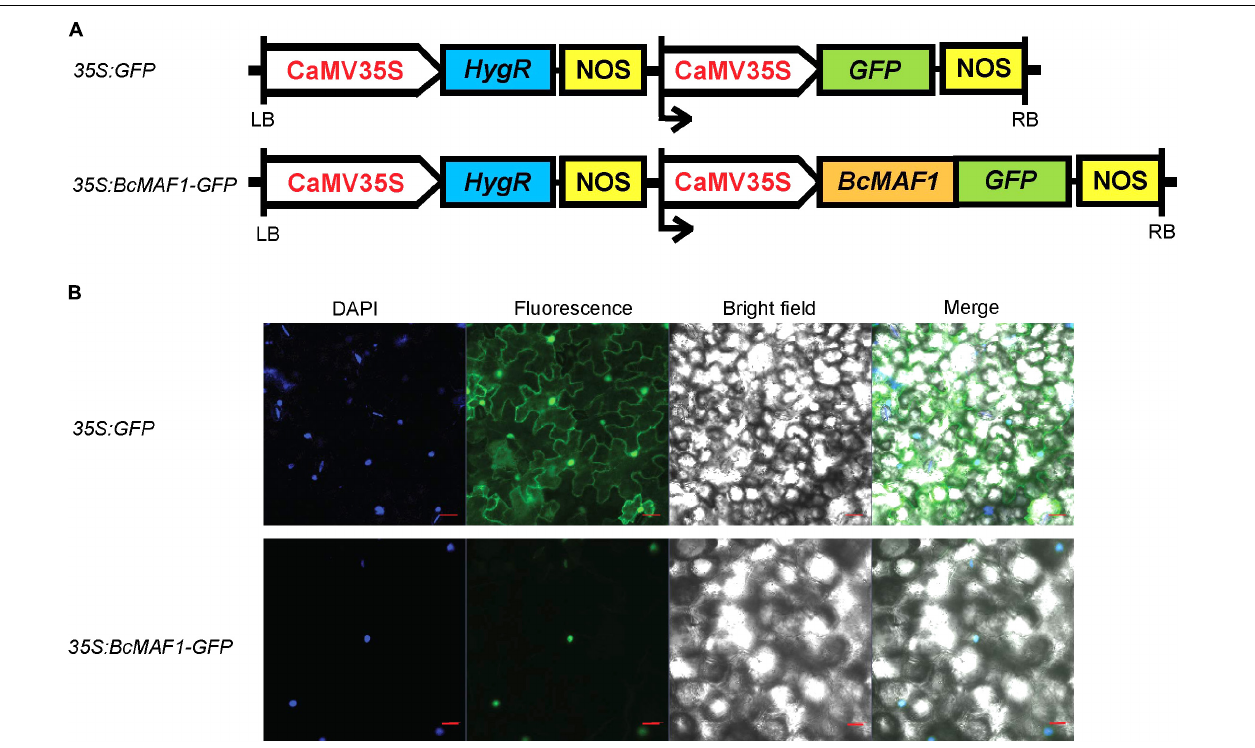
FIGURE 2 | Subcellular localization of BcMAF1 protein. (A) 35S:GFP and 35S:BcMAF1-GFP construct. (B) Transient expression of 35S:GFP (Scale bars = 50 µ m) and 35S:BcMAF1-GFP fusion protein (Scale bars = 20 µ m) in tobacco leaves.